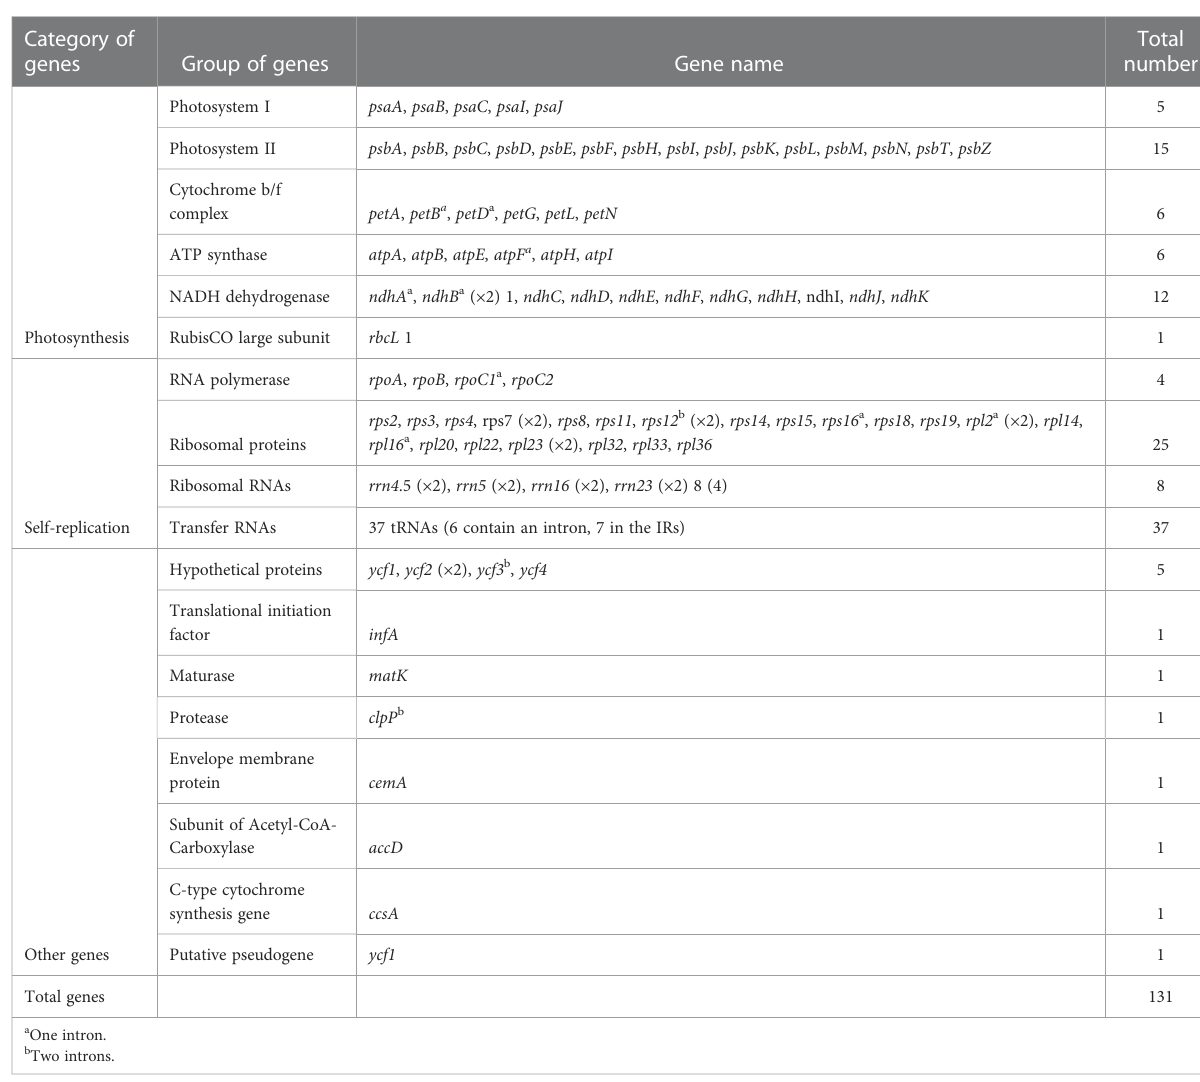
TABLE 1 List of genes in the chloroplast genome of Piper nigrum. Category of genes